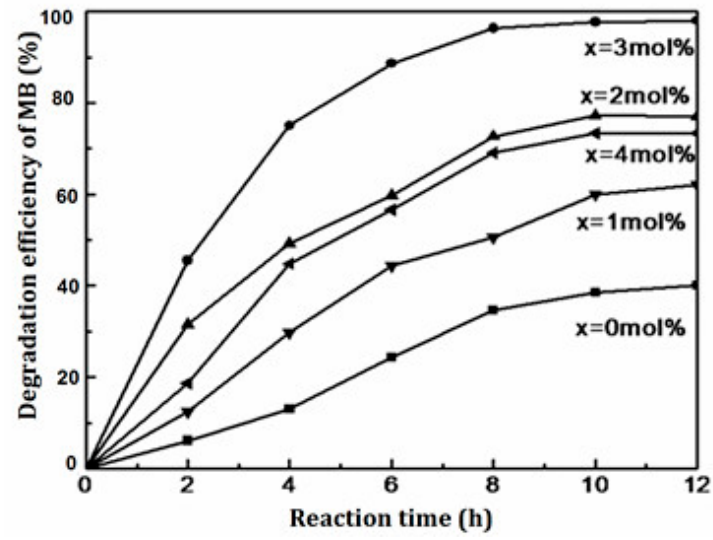
Figure 12. The photocatalytic degradation on MB of 0~4 mol % Ce 4+ doped SrTiO 3 .